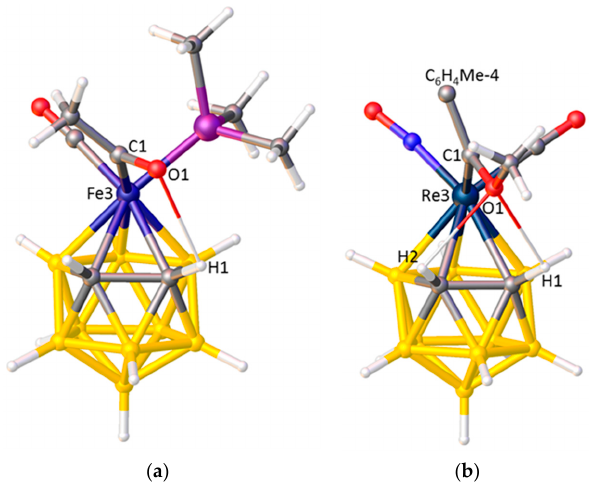
Figure 12. ( a ) The structure of the [3-CO-3-PMe 3 -3-C(O)Me- closo -3,1,2-FeC 2 B 9 H 11 ] − , anion. O1···H1 2.43 Å; ( b ) The structure of [3-NO-3-CO-3-{C(OMe)C 6 H 4 Me-4)- closo -3,1,2-ReC 2 B 9 H 11 ] (C 6 H 4 Me-4 omitted for clarity). O1···H1 2.46, O1···H2 2.49